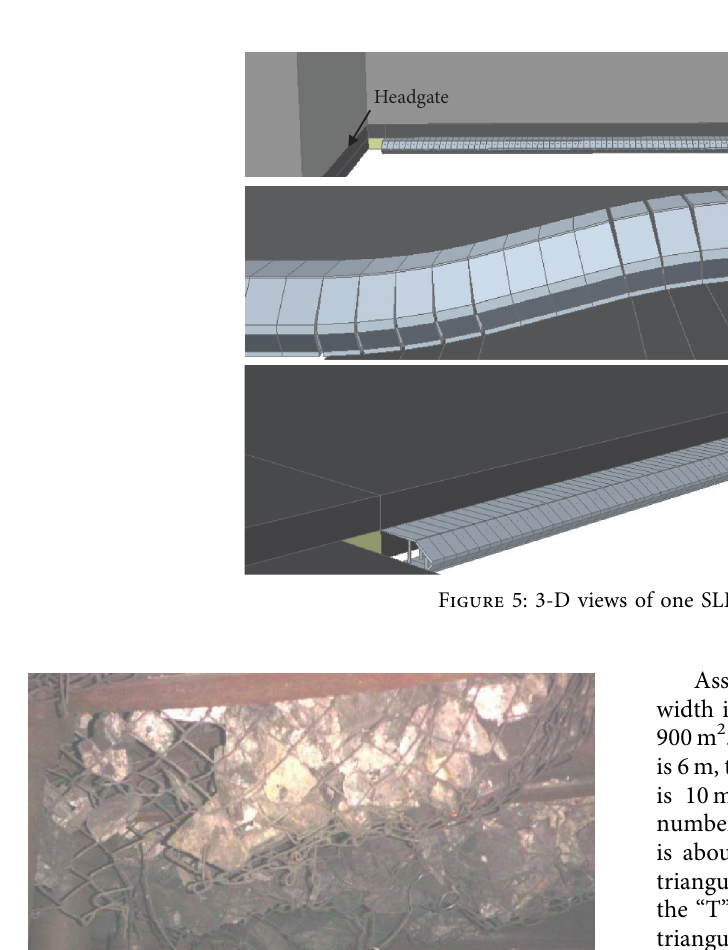
Figure 4: A typical SLL layout with top coal caving in a thick flat coal seam.